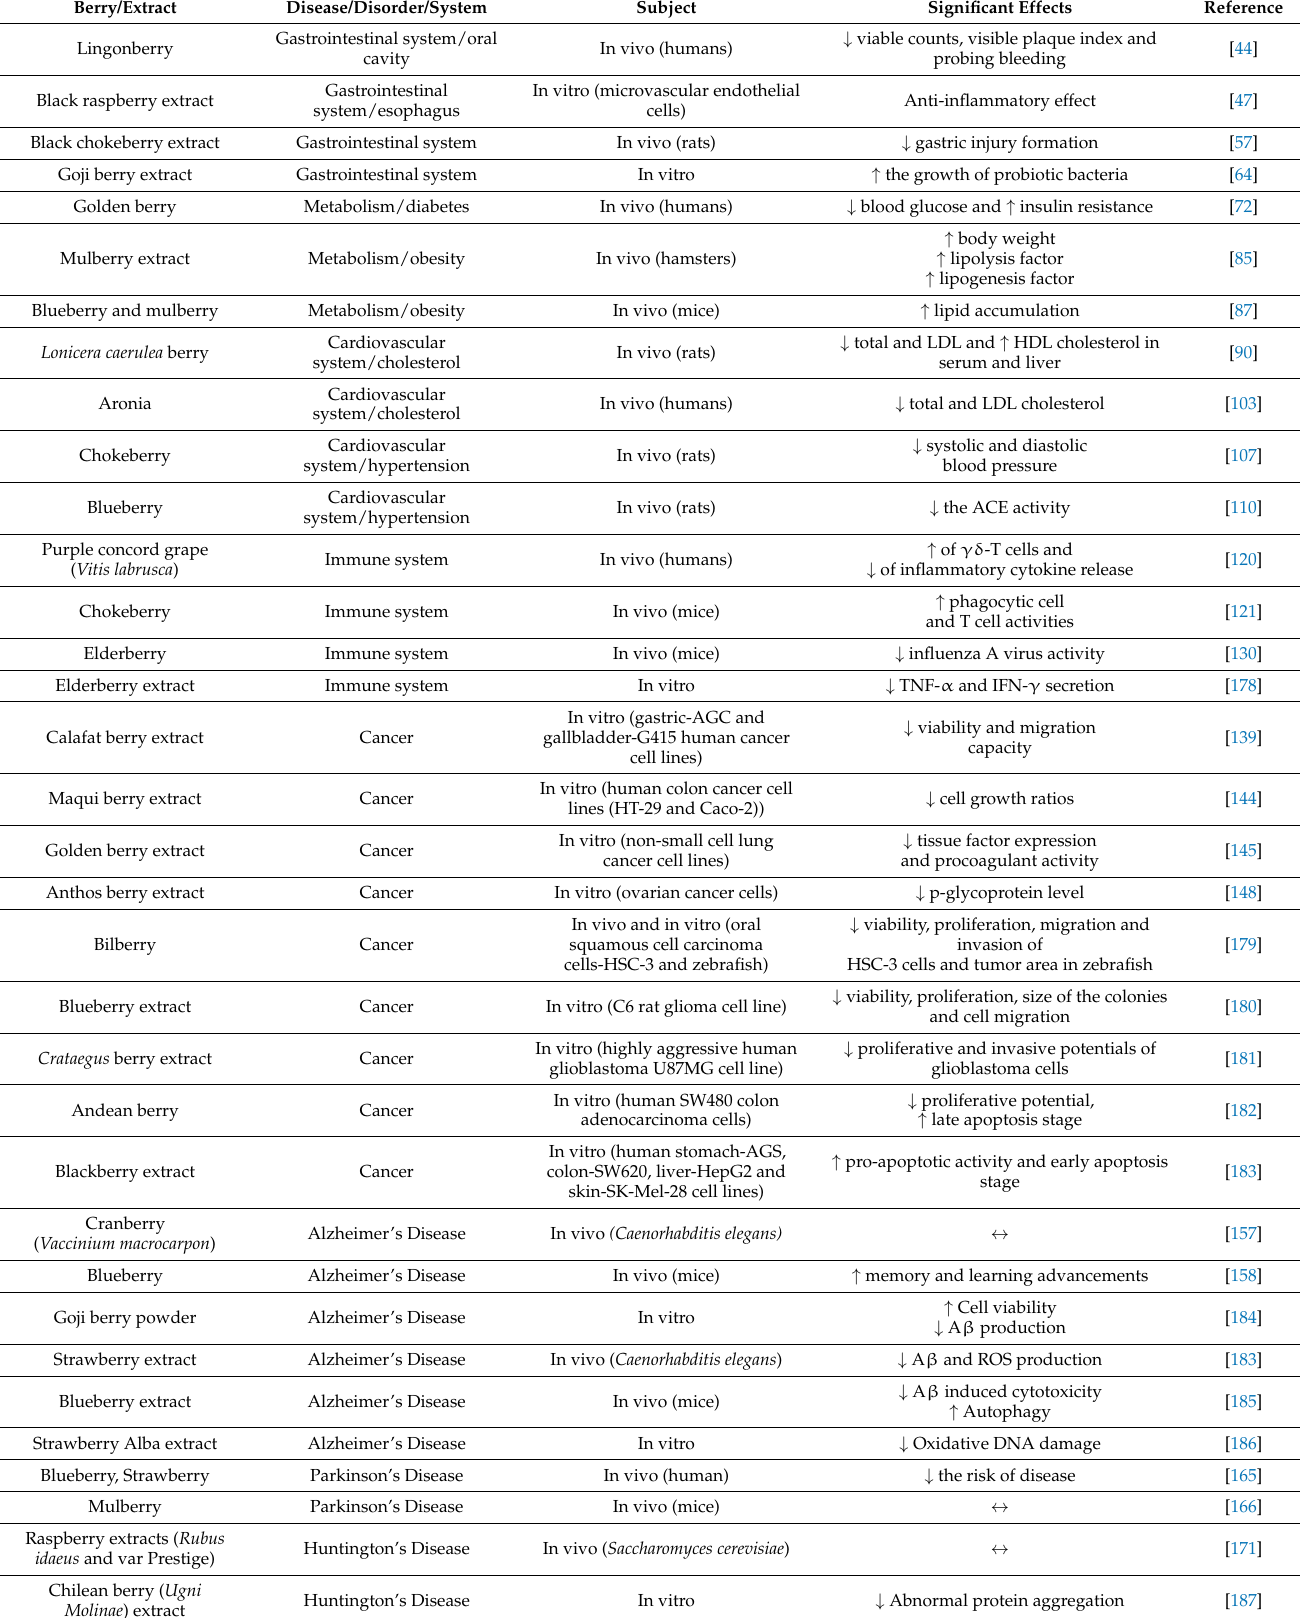
Table 2. Some selected studies related to the effect of berries on various health